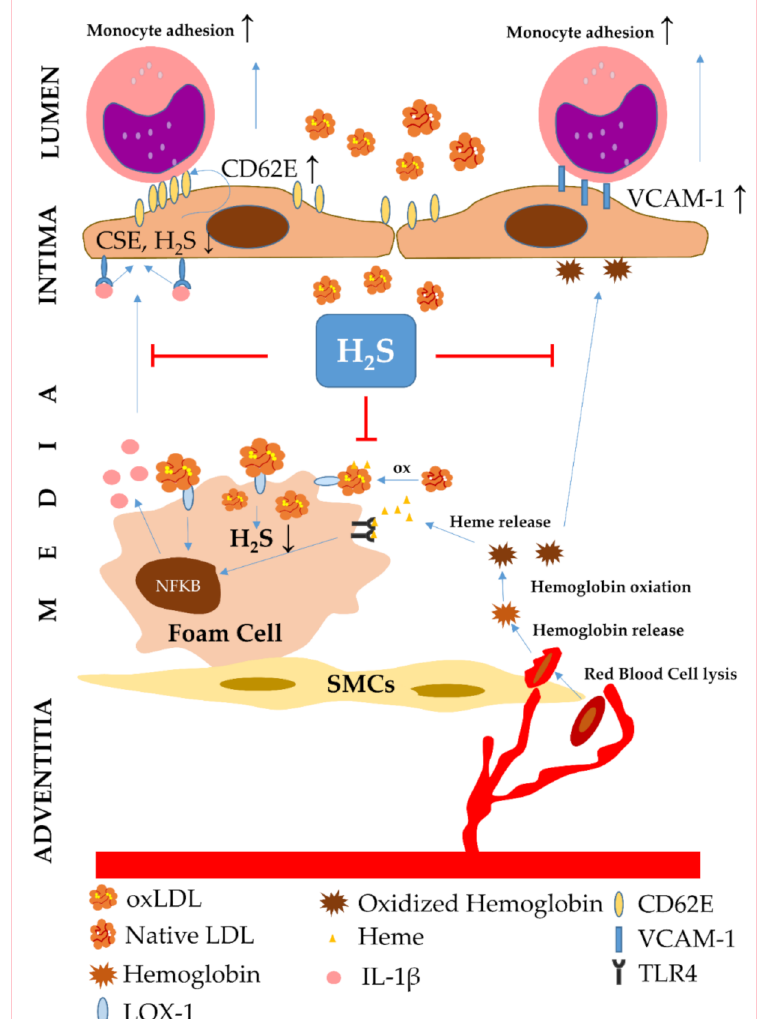
Figure 4. Protective effect of H 2 S on hemoglobin-driven damages in atherosclerosis. Neovascularization, budding of tiny blood vessels from vasa vasorum, is common during atherosclerotic plaque progression due to the thickening of the vessel wall in the plaque area. However, neovascularized capillaries are immature, leading to blood leakage into the great vessel wall. Red blood cells invading the highly oxidative environment of plaques lyze followed by the release and oxidaTable 1. (IL-1 β ). IL-1 β downregulates cystathionine γ -lyase (CSE) activity and hydrogen-sulfide (H 2 S) production in endothelial cells, which induces CD62E expression, leading to monocyte adhesion to the endothelium. Oxidzed Hb also triggers the expression of adhesion molecules, such as vascular cell adhesion protein-1 (VCAM-1), that facilitates monocyte adhesion to the endothelium and their trans-endothelial migration. H 2 S inhibits oxidized LDL-induced inflammation and CD62E expression as well as oxidzed Hb-induced VCAM-1 expression in endothelial cells, inhibiting monocyte adhesion and trans-endothelial migration together with subsequent foam cell formation. CSE: cystathionine γ -lyase; VCAM-1: vascular cell adhesion protein-1; NFKB: nuclear factor kappa-light-chain-enhancer of activated B cells; SMC: smooth muscle cell; oxLDL: oxidized low-density lipoprotein; IL-1 β : interleukin-1 β ; TLR4: toll-like receptor 4; LOX-1: lectin-like oxidized low-density lipoprotein receptor-1; ↑ : increase; ↓ :